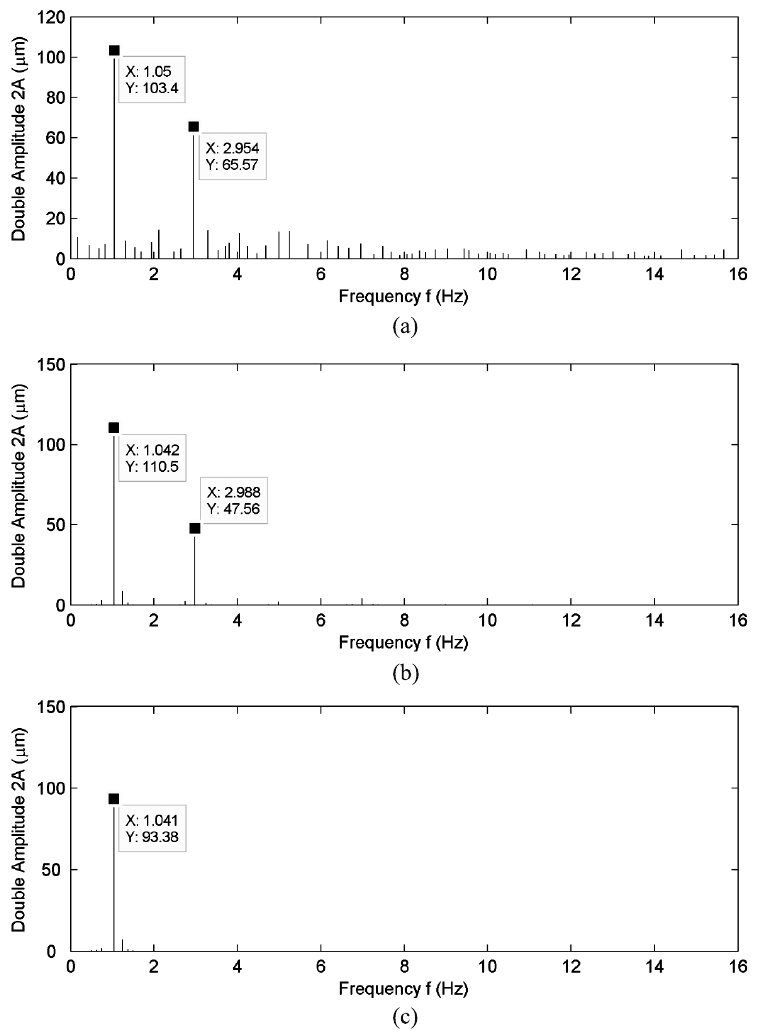
Fig. 11. Comparison of amplitude spectrum for UGB at direction X. (a) Field data; (b) Simulation result of underdamped bearings; (c) Simulation result of damped